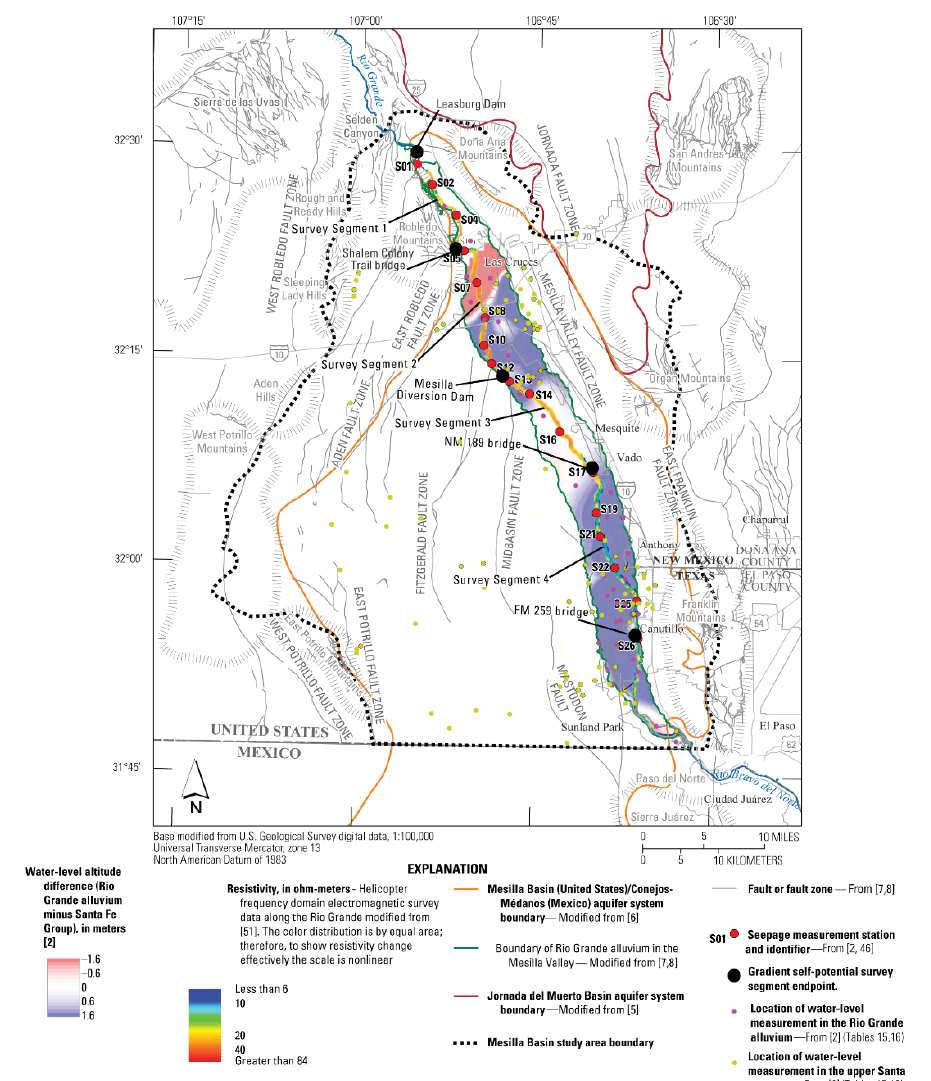
Figure 3. Water-level altitude differences between the Rio Grande alluvium and the Santa Fe Group, with electric resistivity at a depth of 30.5 m beneath the Rio Grande. Water-level differences greater than 0 m indicate that the hydraulic head in the Rio Grande alluvium is greater than the hydraulic head in the upper part of the Santa Fe Group, whereas differences less than 0 m indicate the opposite. Other hydrogeologic features are shown, such as fault zones that intersect the river channel, and the locations of seepage-measurement stations and gradient self-potential survey segment endpoints.